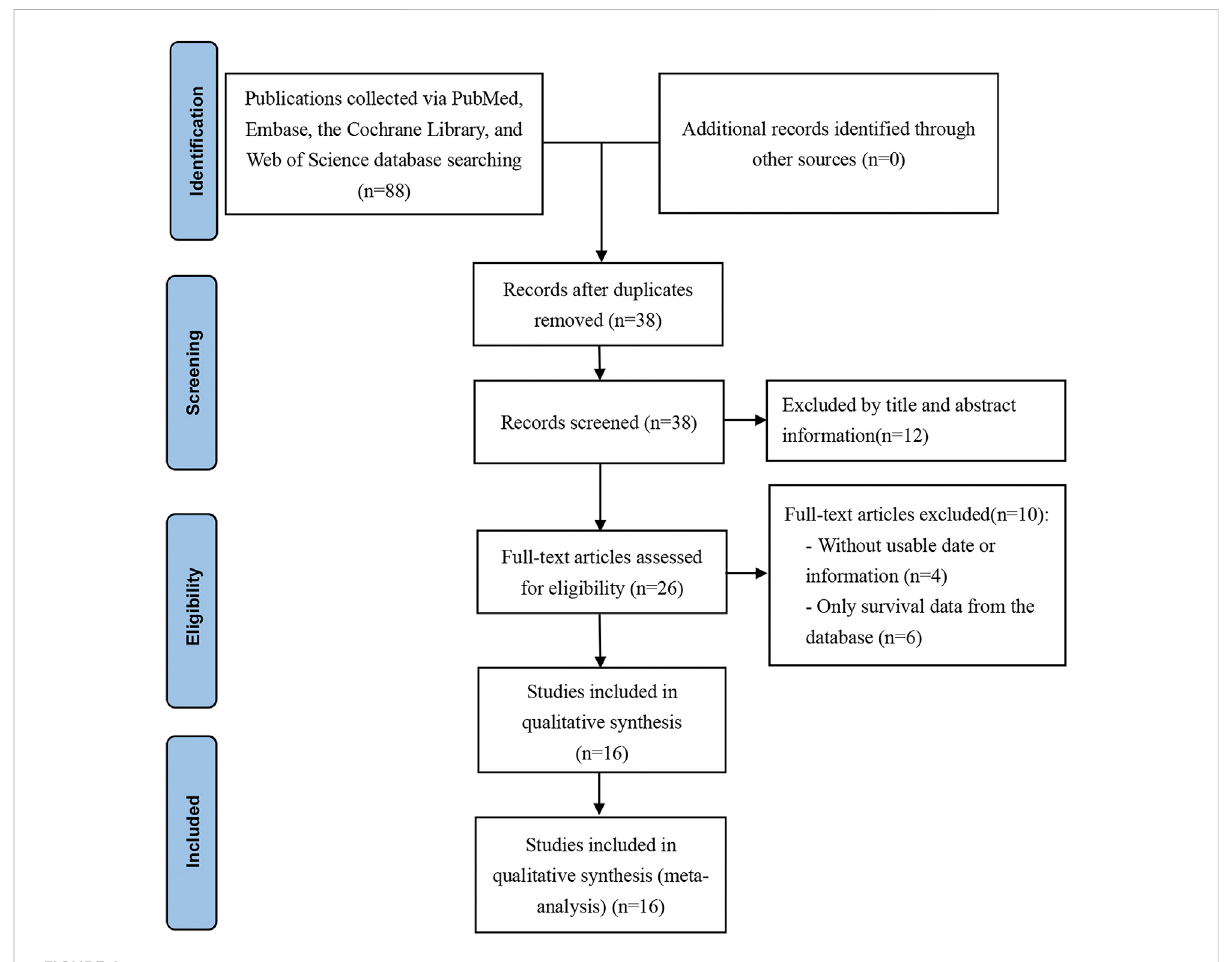
FIGURE 1 Flow diagram of this